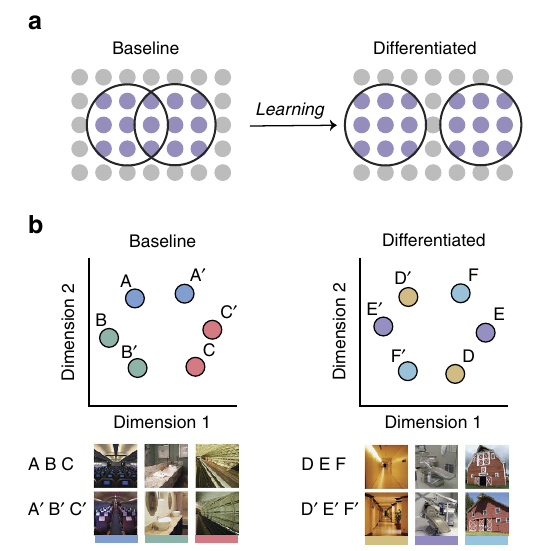
Figure 4 | Schematic illustration of hippocampal differentiation. ( a ) Representational overlap between scene pairmates can be conceptualized in terms of shared feature units. Here, each scene representation (black circle) is composed of active units (purple circles). Before learning (that is, in the ‘Baseline’ or No Face condition), pairmate representations share common features, as reflected by overlap of the black circles. After learning, however, the pairmate representations diverge, with shared units ‘dropping out’ of the representation. ( b ) The representational distance (overlap) between pairmate and nonpairmate representations can be visualized using multidimensional scaling (MDS). Here, neural similarity measures from three No Face scene pairs and three Same Face scene pairs, drawn from a single subject, are projected into a two-dimensional representational space. In the baseline state (No Face condition), the representational distance between pairmates (for example, A and A 0 ) is lower, on average, than between nonpairmates (for example, A and C ). That is, pairmates are ‘clustered’ in representational space. This pairmate clustering corresponds to a positive scene pair difference score. However, learning produces differentiation, pushing pairmate representations apart from one another in representational space and eliminating parimate clustering. After differentiation (Same Face condition), pairmates systematically occupy opposing positions in representational space, resulting in greater representational distances between pairmates than nonpairmates. This corresponds to a negative scene pair difference